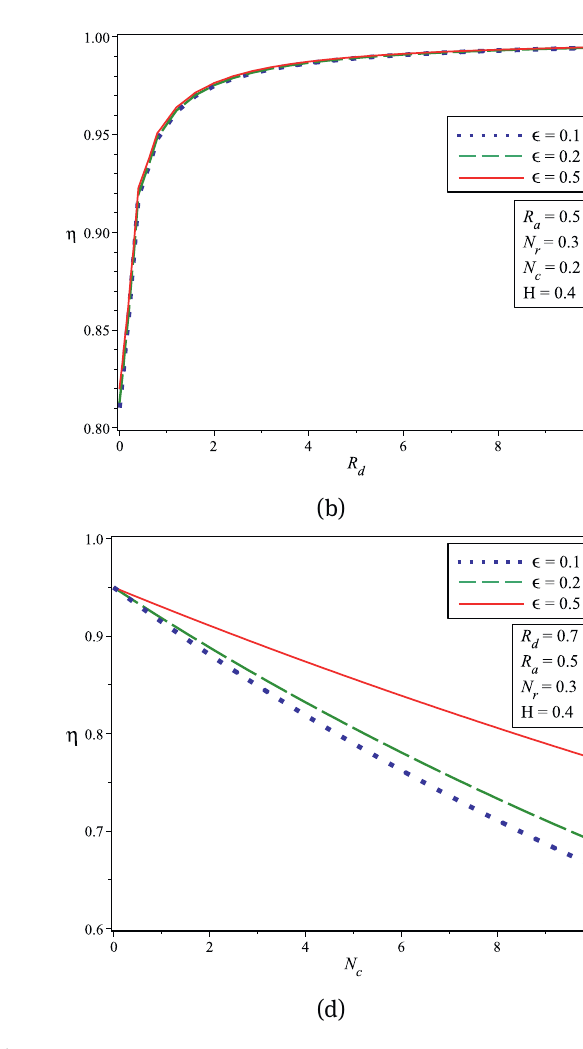
Fig. 10: The variation of efficiency with variation of (a) R a (b) R d (c) N r (d) N c for different porosity ϵ